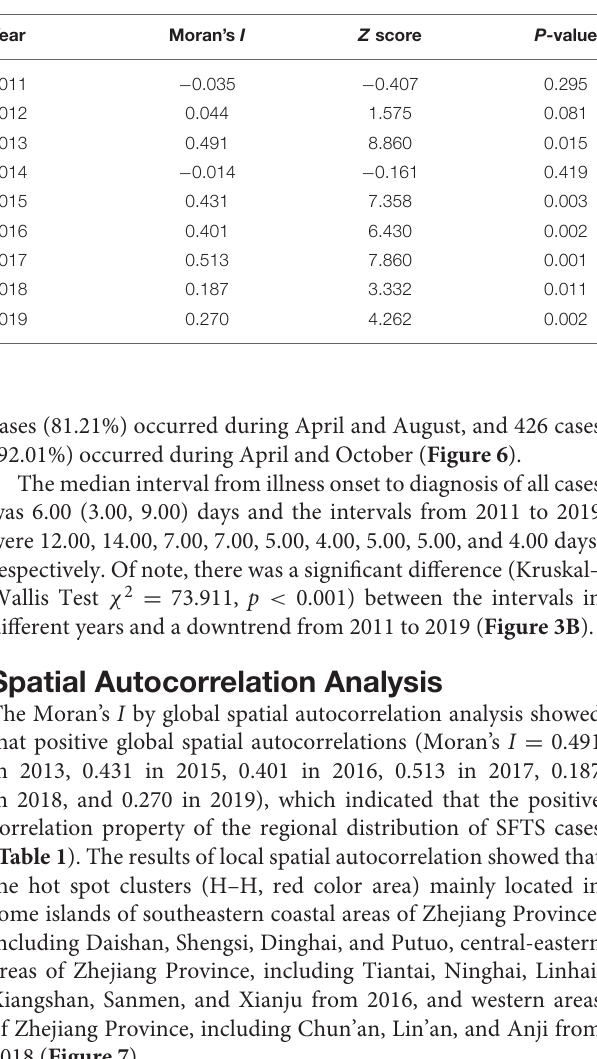
TABLE 1 | The Moran’s I of global spatial autocorrelation analysis during